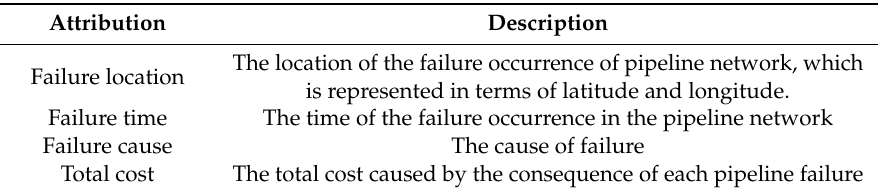
Table 3. Information about each failure event contained in the data.